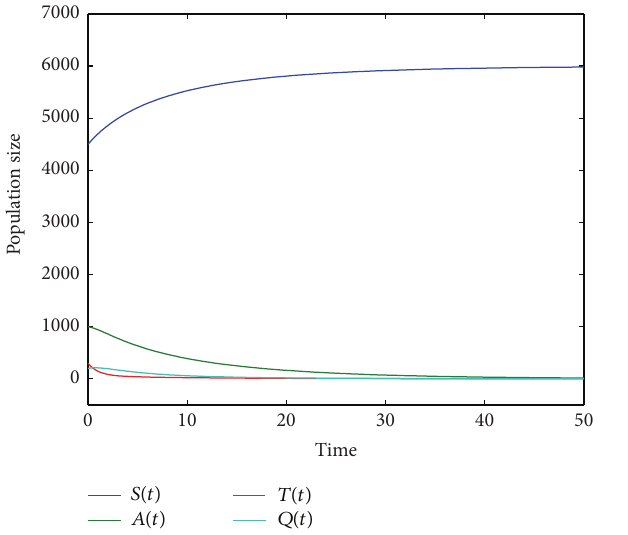
Figure 2: When 𝑅 0 < 1 , the alcohol free equilibrium 𝐸 0 is globally asymptotically stable (𝛽 = 0.2, 𝛿 = 0.3 , and 𝑅 0 = 0.71698) .